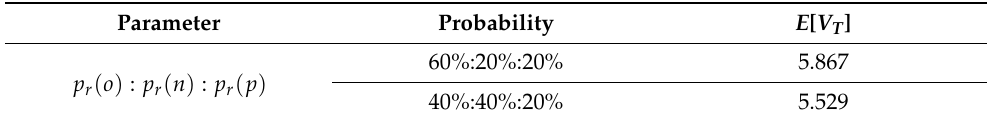
Table 8. Optimal risk probability for the estimated total project value. Currency: US$ Unit: million